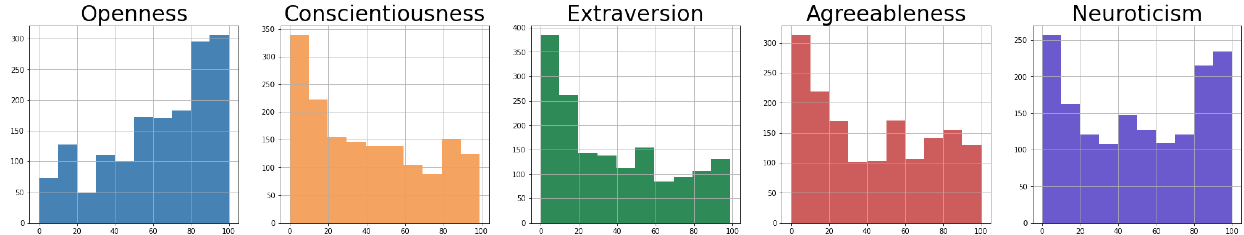
Figure 6. Probability distribution for each of the Big Five personality trait labels present in the PANDORA dataset. While the previous research has suggested Big Five traits usually follow a normal distribution, labels present in the PANDORA dataset [7] seem to follow a more skewed